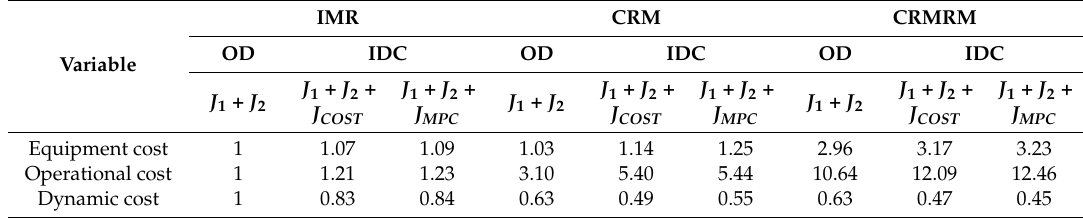
Table 5. Normalized values of each term of the objective function at the optimal point for the three alternative flowsheets, alternative procedures (IDC and OD) and alternative indices ( J COST and J MPC ).